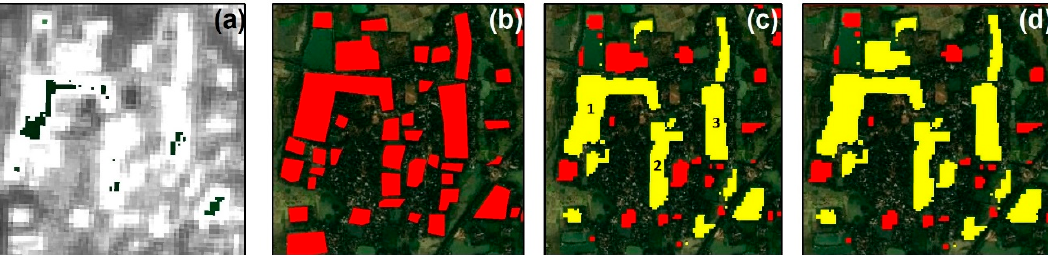
Figure 7. Examples of unsatisfactory classification results. Red polygons represent fishponds and yellow polygons represent water bodies identified by spectral filtering and rejected by spatial filtering. From subfigure ( a – d ): AWEI image on 30 April 2020, ground truth data, classification results by DT, classification results by LR.